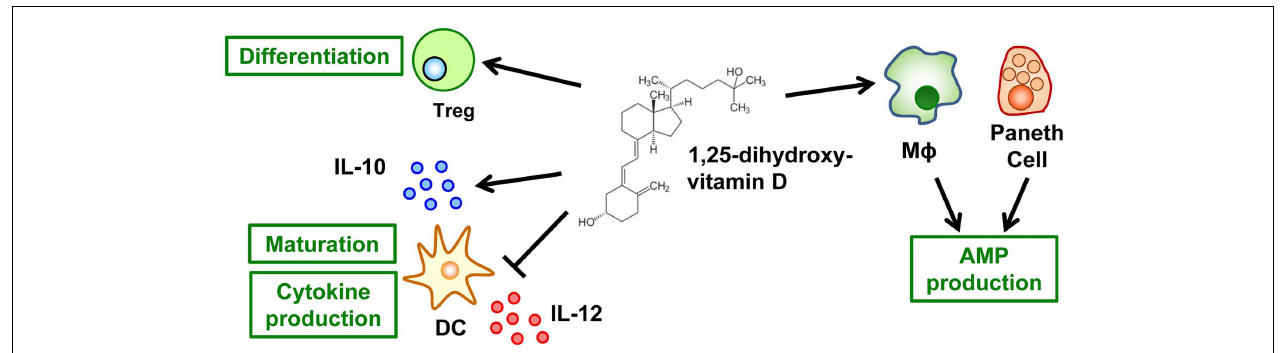
directly to 1,25-dihydroxyvitamin D for their preferential differentiation intoT reg cells. As a component of innate immunity, 1,25-dihydroxyvitamin D promotes the production of anti-microbial peptides (AMP) by macrophages and Paneth